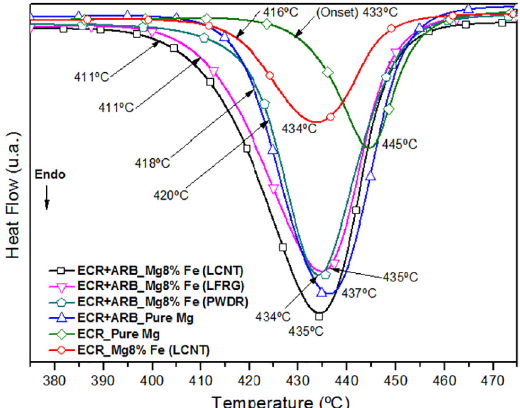
Figure 6. DSC thermograms of Mg-8 mol% Fe samples with different morphologies of Fe processed by ECR and ECR+ARB after 3 cycles of hydrogen absorption.